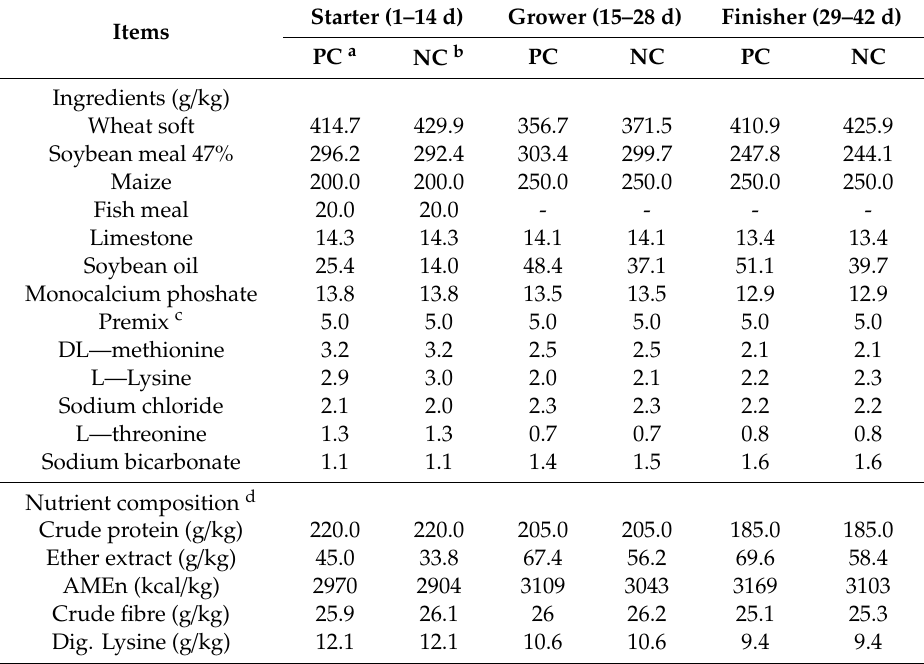
Table 1. Ingredient and nutrient composition of the experimental diets according to the stage of growth (on dry matter